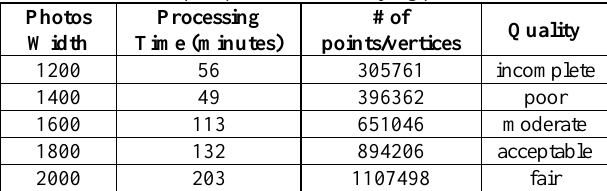
Table 5. Output qualities from varying photo